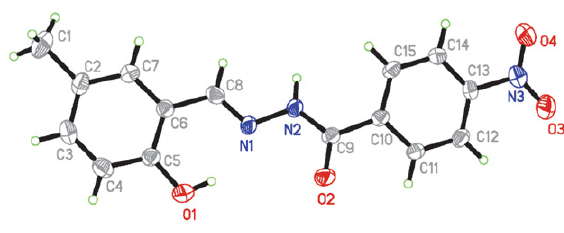
Figure 5. A perspective view of the molecular structure of 3 show- ing the atomic labeling scheme. The thermal ellipsoids are drawn at the 30% probability